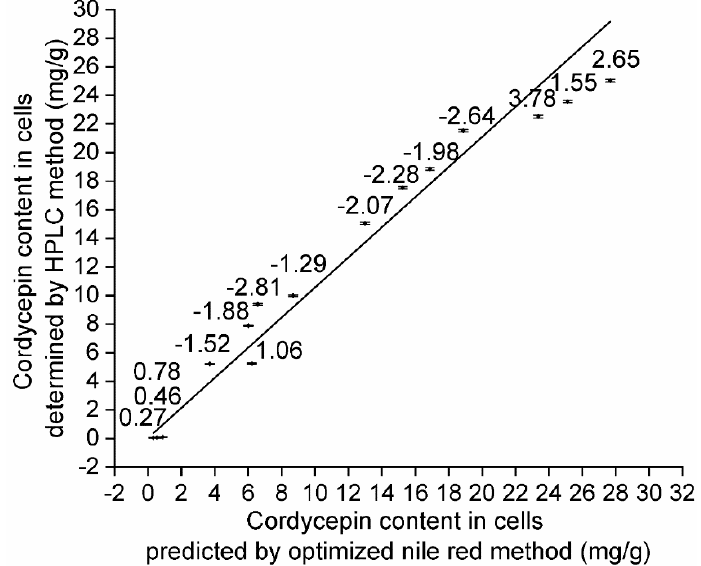
Figure 7. The relationship between cordycepin content in LMP determined by HPLC and that measured by the optimal Nile red method. The data near each point is the absolute error of cordycepin content in LMP individually measured by two methods, and the absolute error is expressed as y = a − b (y: absolute error; a: predicted value measured by the optimal Nile red method; b: true value determined by HPLC method). The relative error of all samples is less than 6%, which can be expressed as y = ((a − b) ÷ b) × 100% (y: relative error; a: predicted value measured by the optimal Nile red method; b: true value, determined by HPLC method).